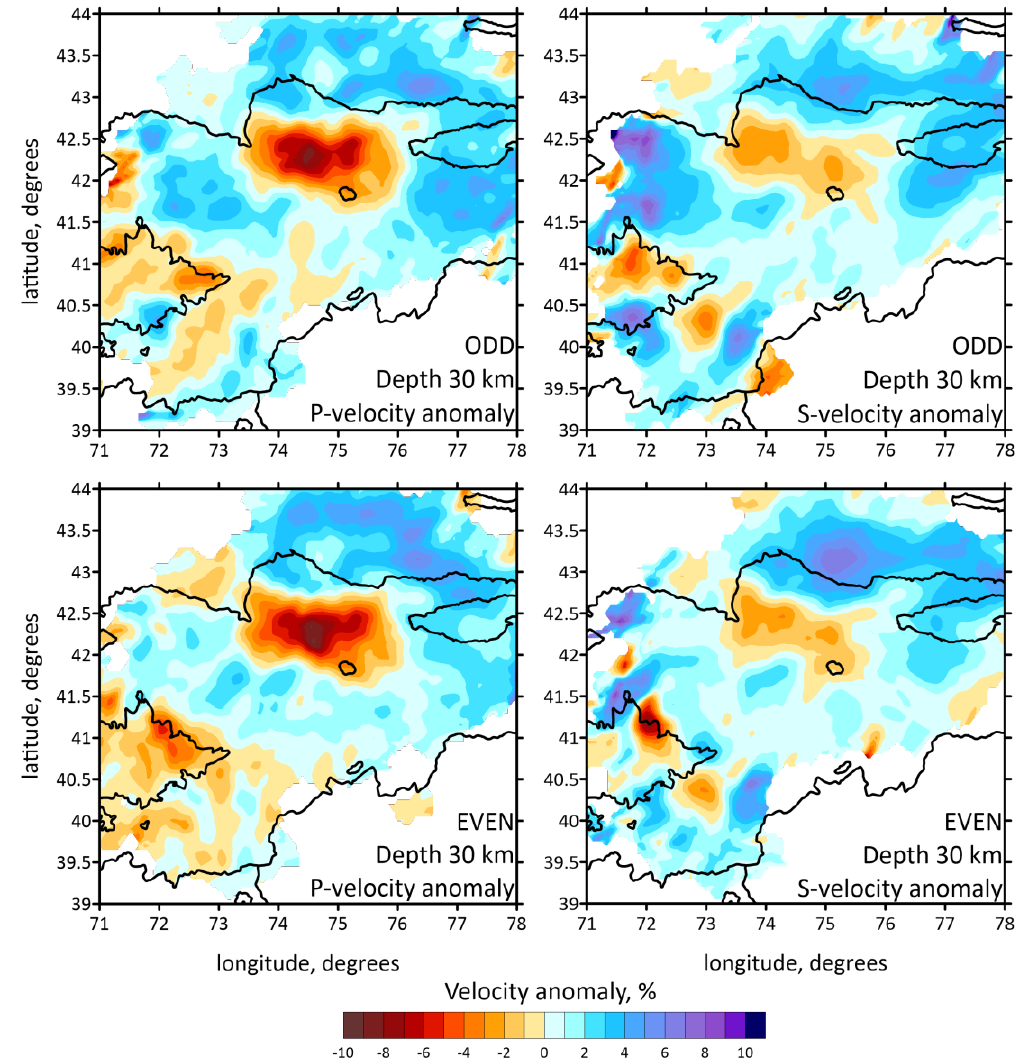
Figure 6. Test with even and odd events in the horizontal sections. The depth is 30 km.